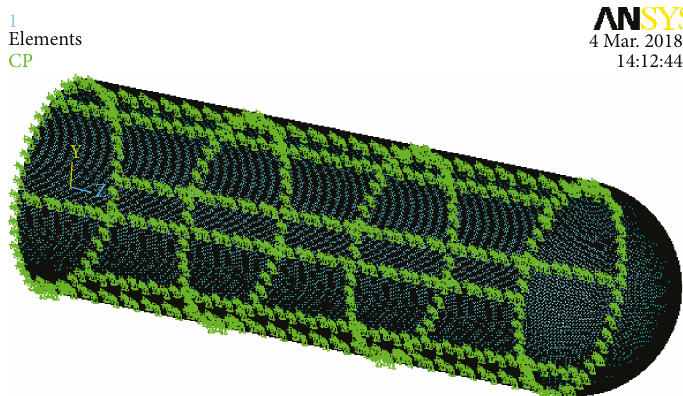
Figure 9: Connection between deployable truss and fl exible composite